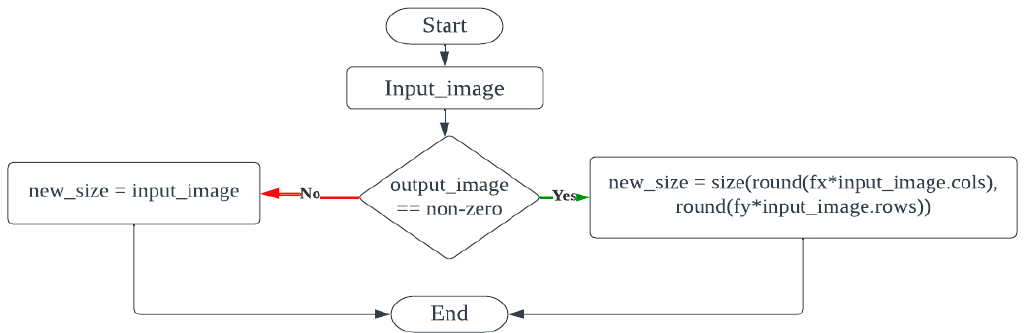
Figure 4. The overall process of resizing images.